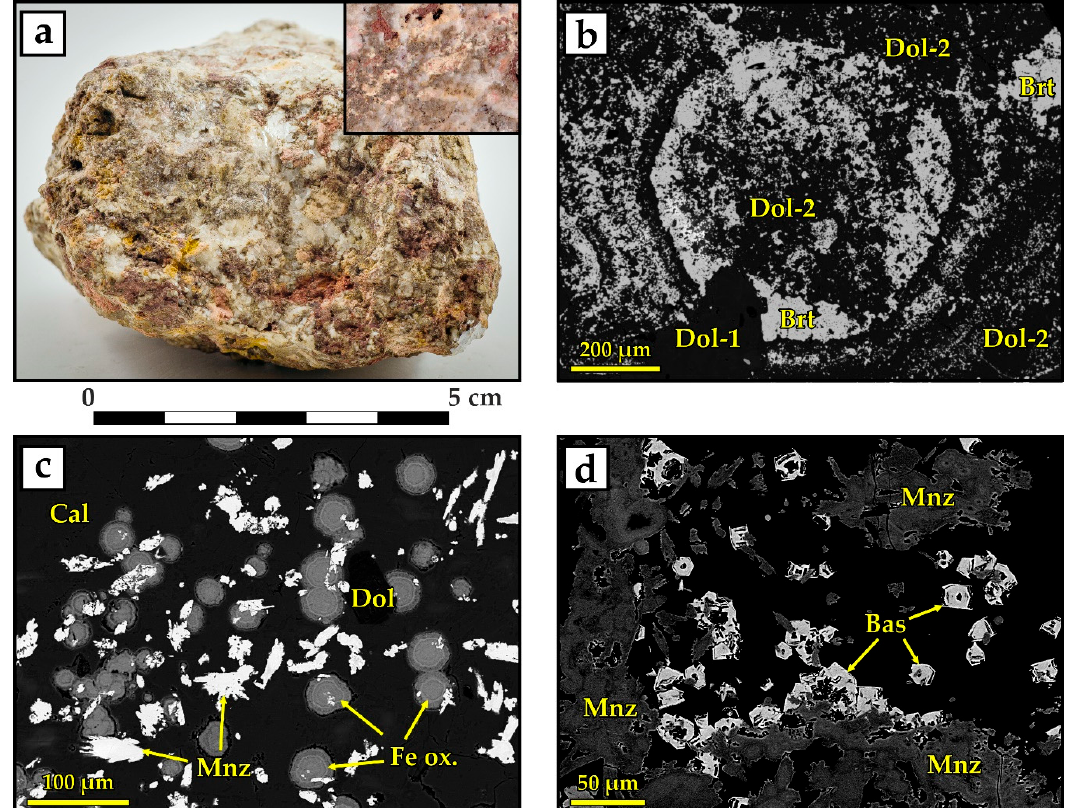
Figure 10. Baryte assemblage. ( a ) Baryte-dominant magnesiocarbonatite, in the inset photo—a polished section with primary dolomite (light grey), dolomite–baryte dissolution cavities (brown), and late caverns filled with minerals of ancylite and strontianite assemblages (red and light pink). ( b ) Collomorphic texture composed of baryte and secondary dolomite Dol-2. ( c ) Collomorphic texture of iron oxides and hydroxides and sheaves of monazite crystals. ( d ) Euhedral bastnäsite crystals at the edges of a colloform monazite. Photomicrographs ( b – d ) are in the backscattered electrons (BSE).